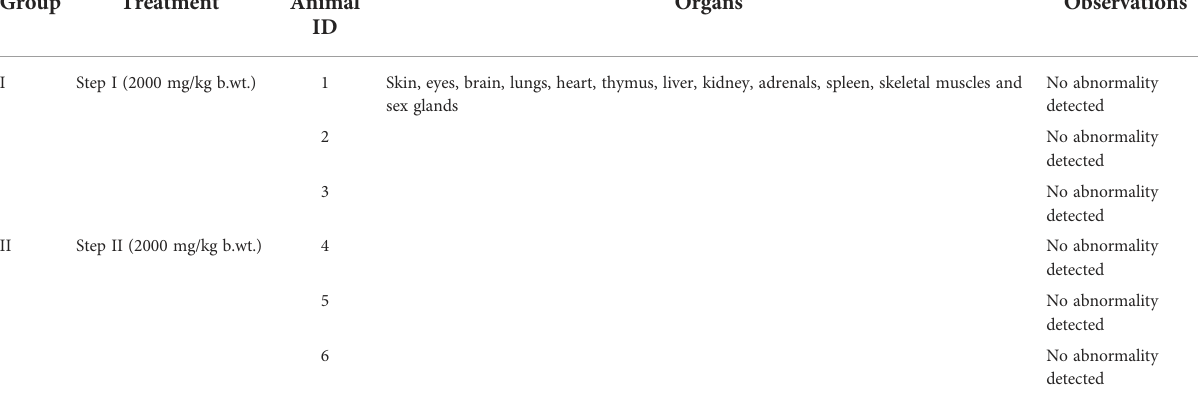
TABLE 2 Gross pathological observation of individual animals.